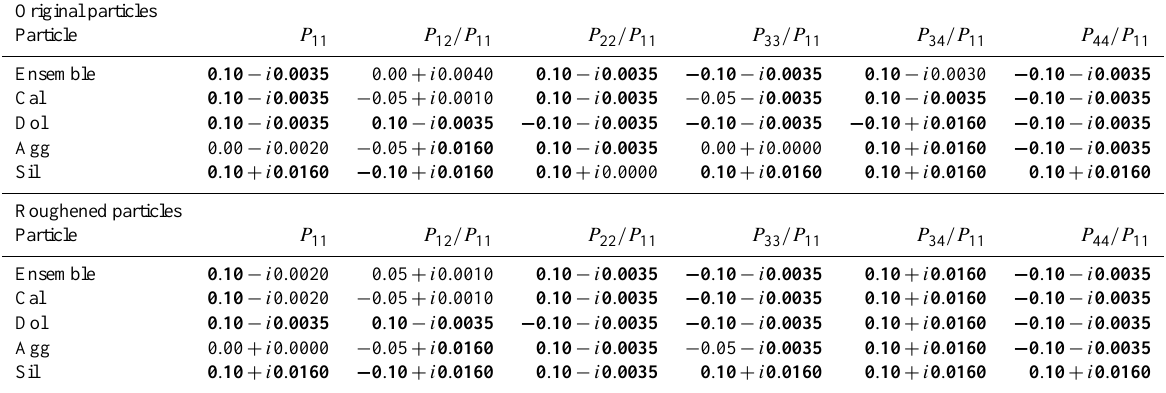
Table 3. Complex refractive index errors for the uniform shape distribution. Original particles